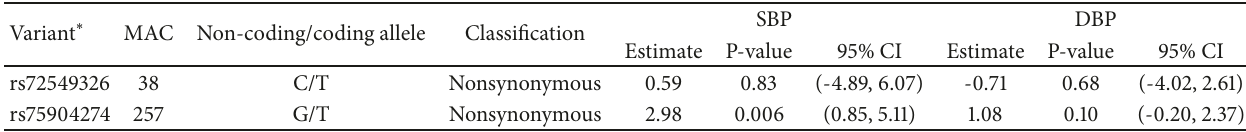
Table 5: Results from low-frequency single-variant analysis of FMO3 with SBP and DBP as outcomes in European Americans. Variant